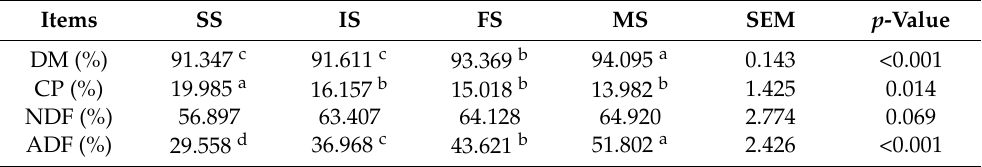
Table 2. Nutrient compositions of Amaranthus hypochondriacus hay in different growth stages. Items SS IS FS MS SEM p -Value DM (%) CP